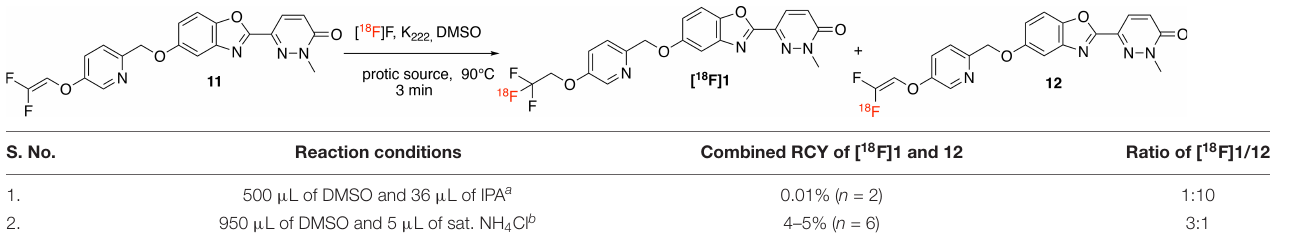
TABLE 2 | Conditions for the radiosynthesis of [ 18 F]1 .